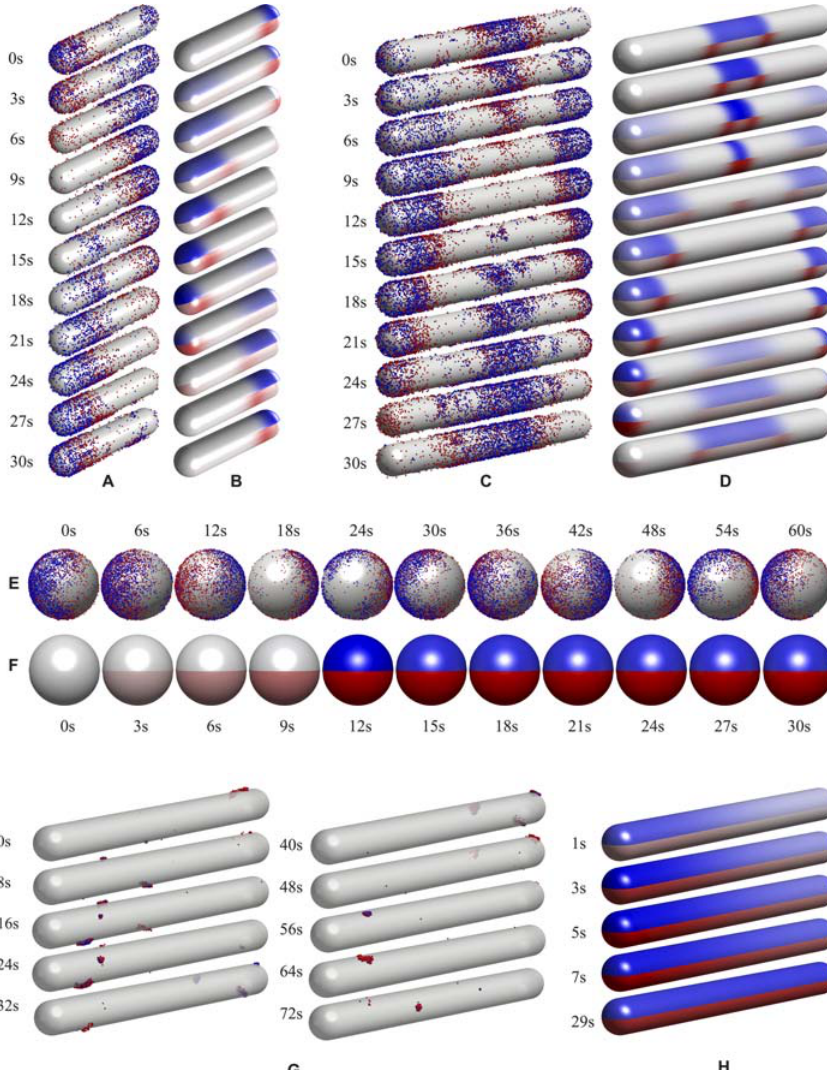
Figure 3. Comparison of Stochastic and Mean-Field Simulations in wt E. coli Cells and Three Different Mutant E. coli Strains The wt geometry (A) and (B), filamentous geometry (ftsZ (cid:1) ) (C) and (D), spherical geometry (rodA (cid:1) ) (E) and (F), and PE (cid:1) cells with filamentous geometry (G) and (H) are shown. (A), (C), (E), and (G) show the stochastic simulations and (B), (D), (F), and (H) show the mean-field simulations. Membrane-bound MinD is shown in blue, and MinE in complex with MinD on the membrane is shown in red. The cells in (B), (D), (F), and (H) have been divided into two halves (upper and lower) to show both the MinD and the MinE concentration fields in the same plot. The discretized solution of the mean-field simulations has been mapped onto a smooth surface to facilitate visualization. In (G), the cell surface is transparent to allow visualization of the clusters on the back. DOI: